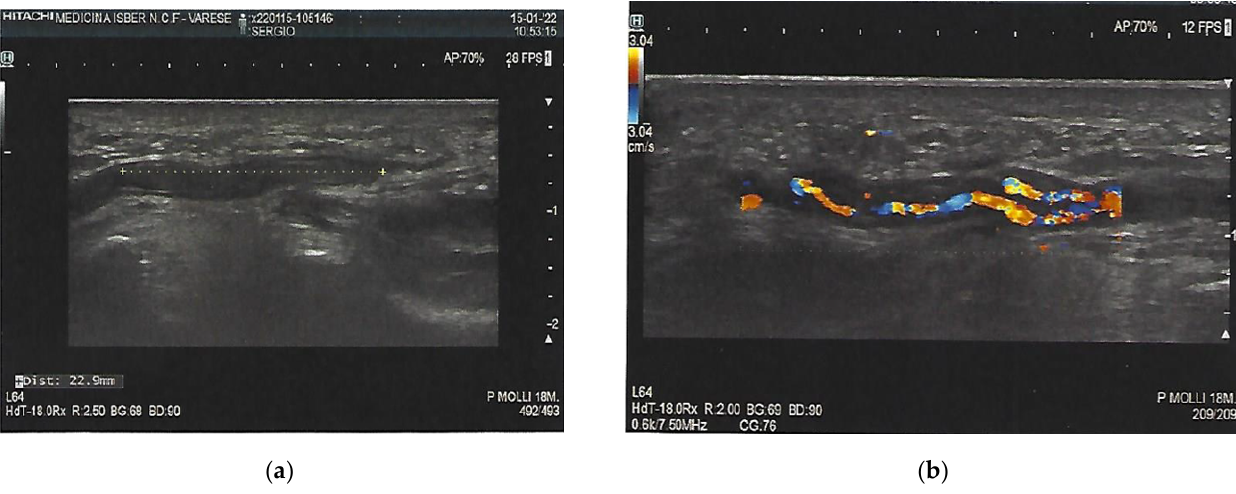
Figure 3. Reduction in the length of the thrombus after 10 days ( a ); Doppler ultrasound after 10 days with reduction in the length and thickness of the thrombus (22.9 mm vs. 30.0 mm) ( b ).